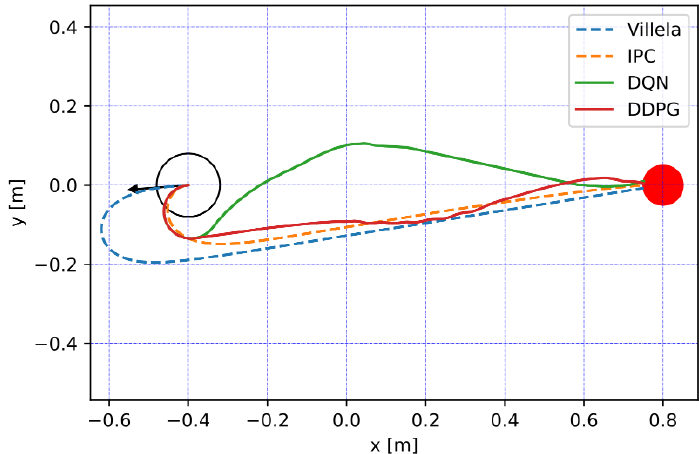
Figure 9. Graph of the trajectory of the experiment without obstacles.